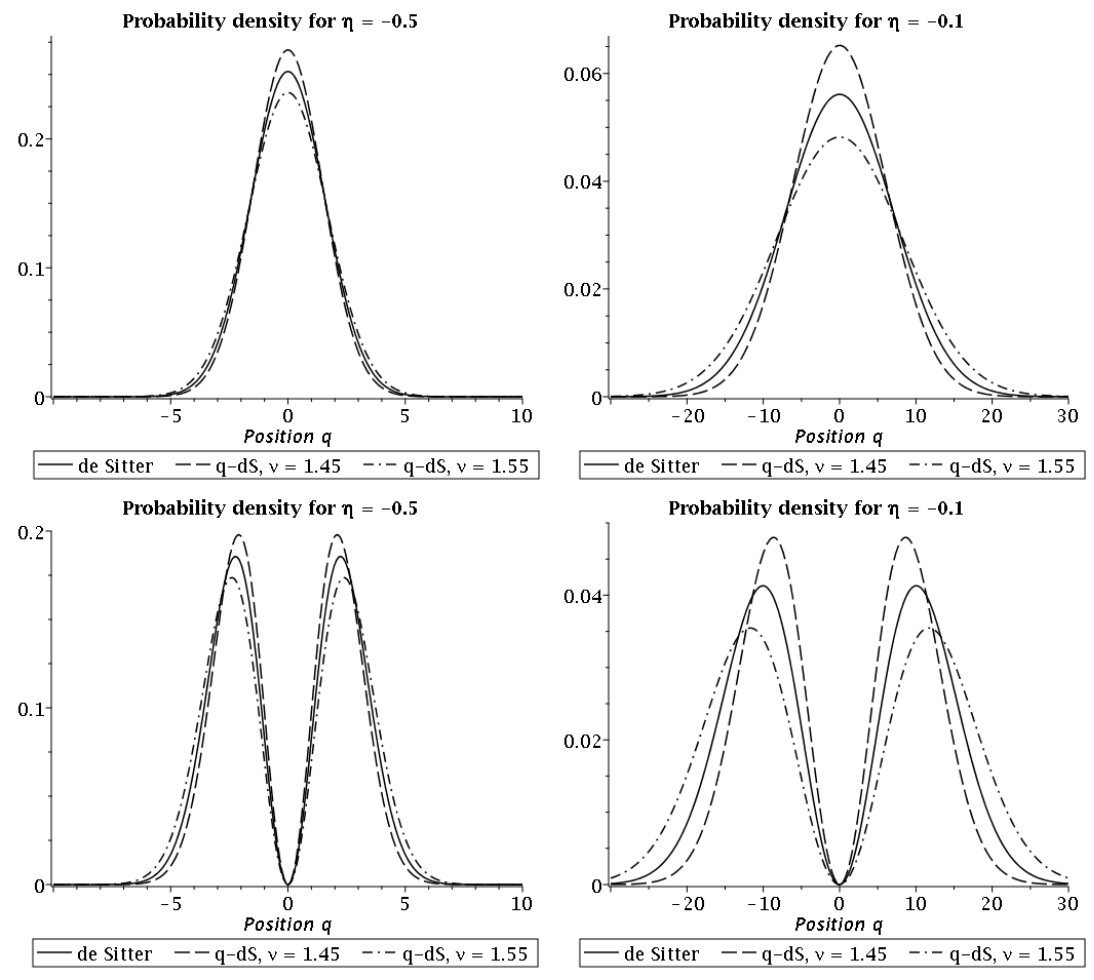
Figure 2. Single-mode probability densities | Ψ 0 ( q , η ) | 2 (upper line) and | Ψ 1 ( q , η ) | 2 (lower line) according to the solutions in (89) and (90) on quasi-de Sitter for three different values of the effective slow-roll parameter ν from Equation (58), including de Sitter with ν = 3/2 at two different conformal times and with ω 0 = k = 1. The used slow-roll parameters are to be understood as an example, consider Reference [33] for the allowed parameter space and constraints on them according to the Planck